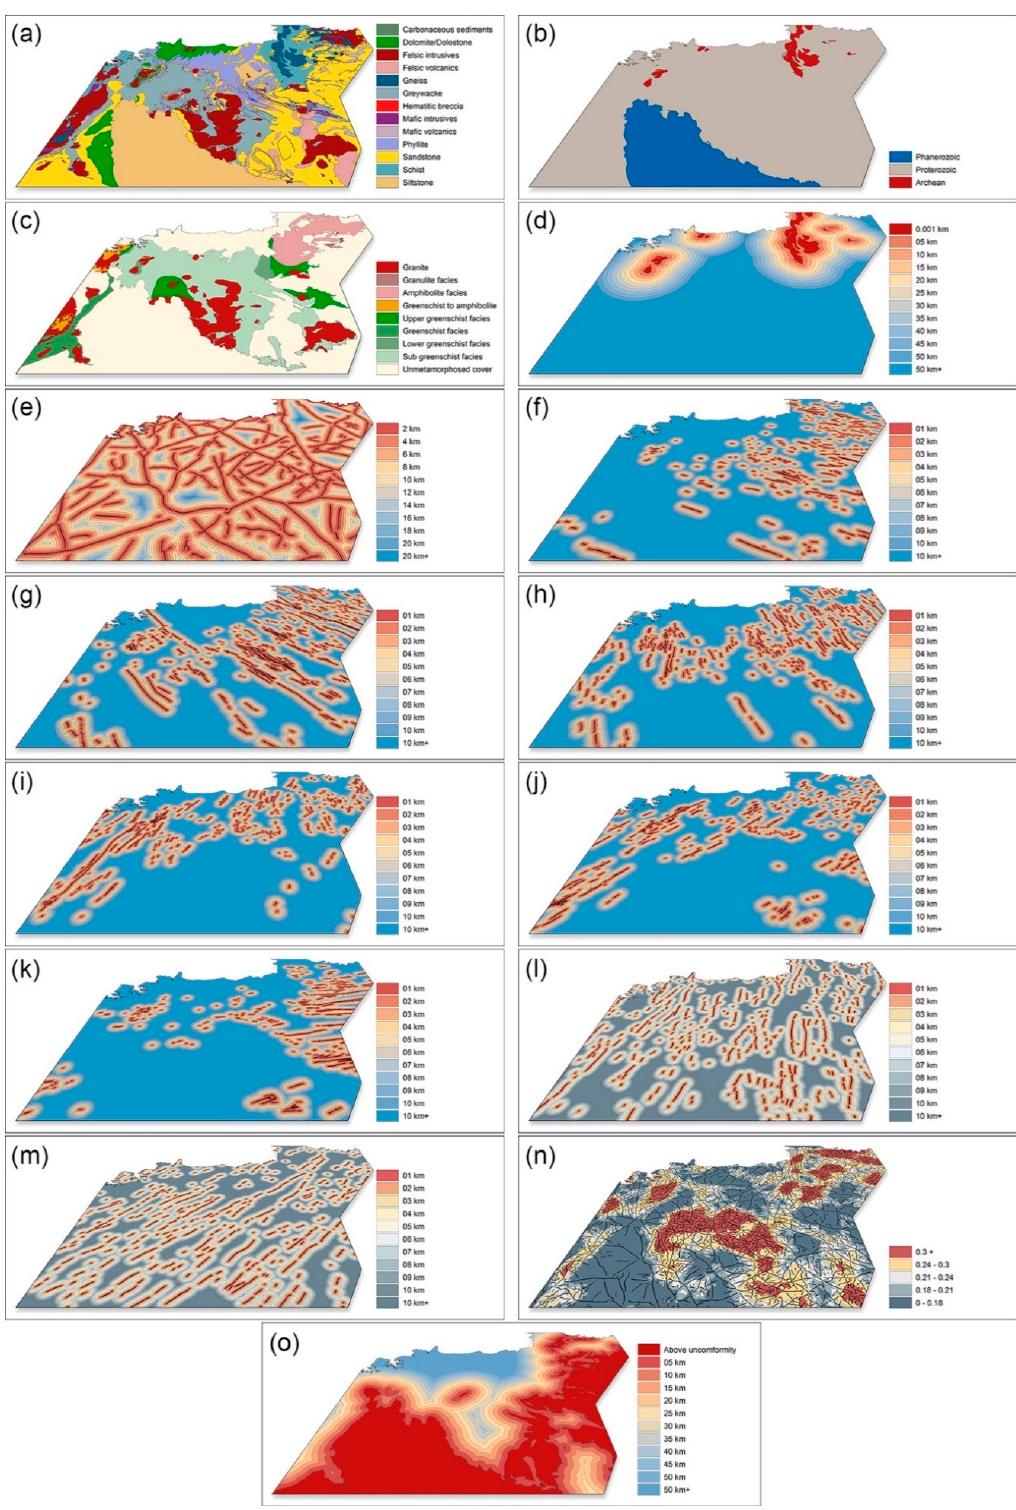
Figure 8. NW McArthur Basin predictors viewed looking north: ( a ) Simplified lithology, ( b ) simplified stratigraphy, ( c ) metamorphic regions, ( d ) Archean bu ff ered, ( e ) gravity edges 6400 bu ff ered, ( f ) faults WNW bu ff ered, ( g ) faults NW bu ff ered, ( h ) faults NNW bu ff ered, ( i ) faults NNE bu ff ered, ( j ) faults NE bu ff ered, ( k ) faults ENE bu ff ered, ( l ) gravity edges 1600 NNE bu ff ered, ( m ) gravity edges 1600 NE bu ff ered, ( n ) magnetic 1600 edge density and ( o ) unconformity bu ff